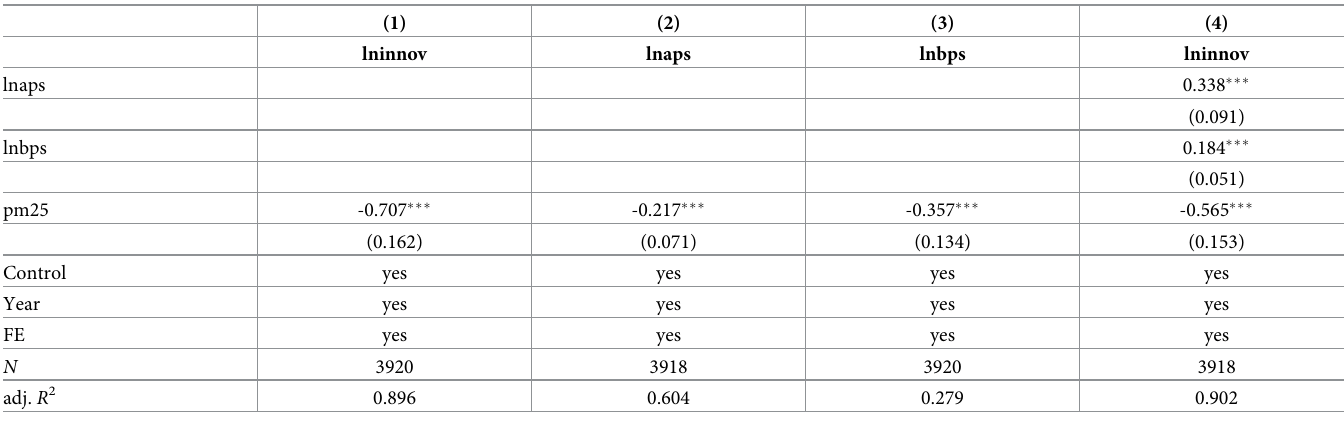
Table 8. Advanced productor services (aps) and basic productor services